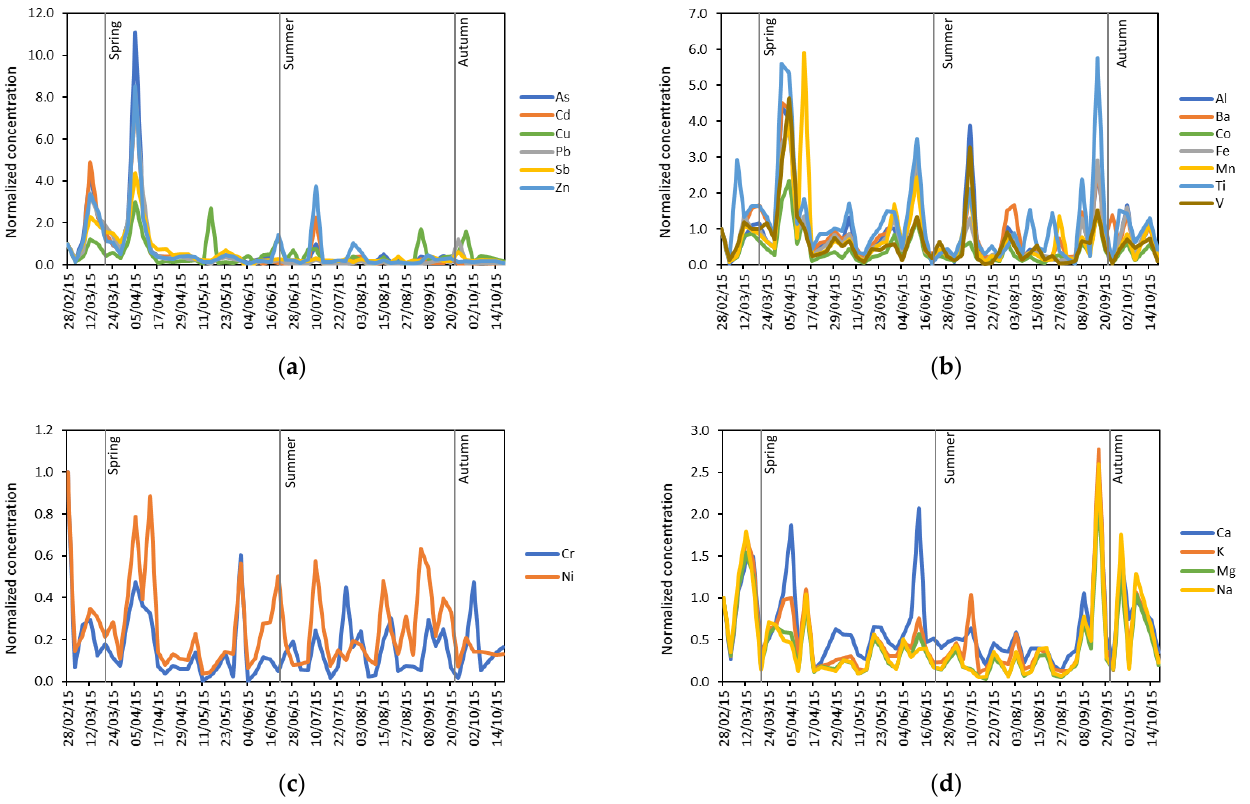
Figure 3. Seasonal trends registered for the four clusters of elements emerged from HCA: ( a ) As, Cd, Cu, Pb, Sb, Zn; ( b ) Al, Ba, Co, Fe, Mn, Ti, V; ( c ) Cr, Ni; ( d ) Ca, K, Mg, Na.